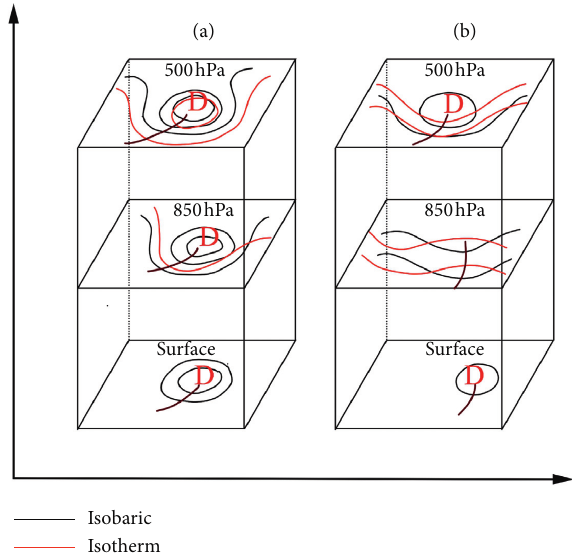
Figure 1: Sketches of (a) strong cold vortices and (b) weak cold